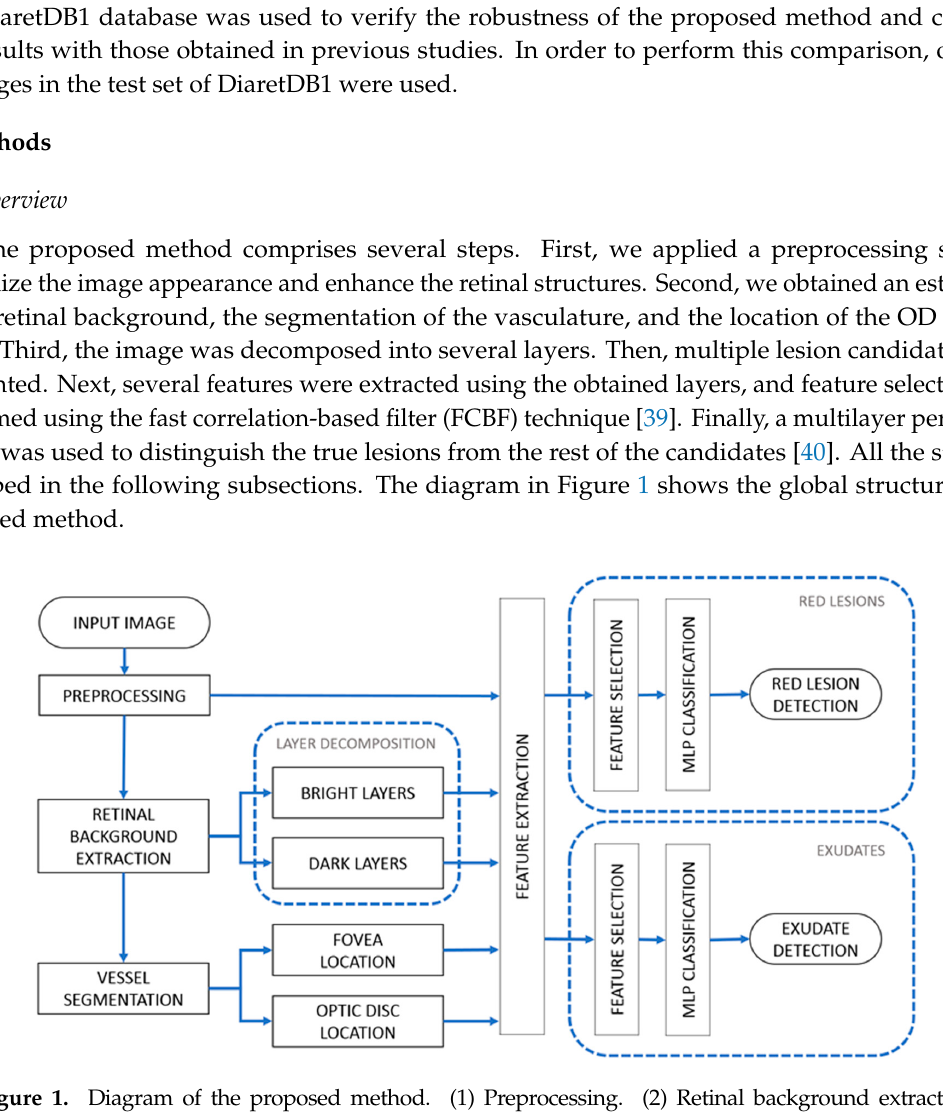
Figure 1. Diagram of the proposed method. (1) Preprocessing. (2) Retinal background extraction. (3) Vessel segmentation, optic disc location, and fovea location. (4) Layer decomposition. (5) Feature extraction and selection. (6) Multilayer perceptron (MLP) classification.